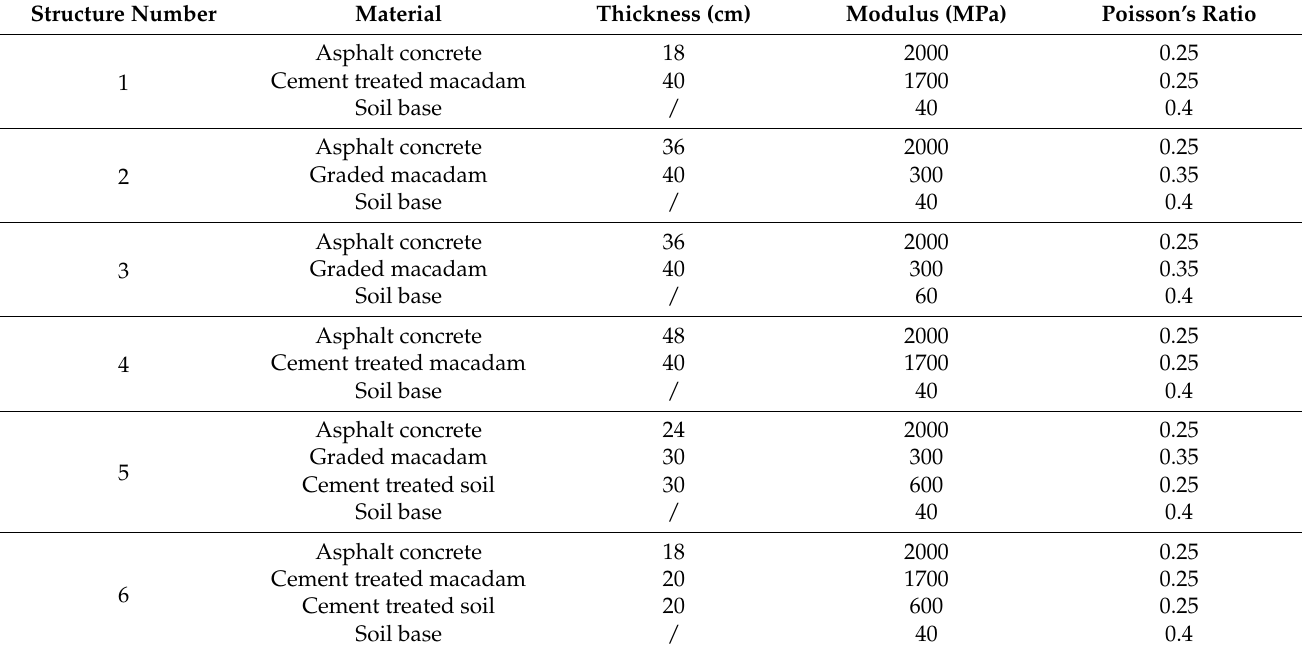
Table 1. Material and structure parameters.